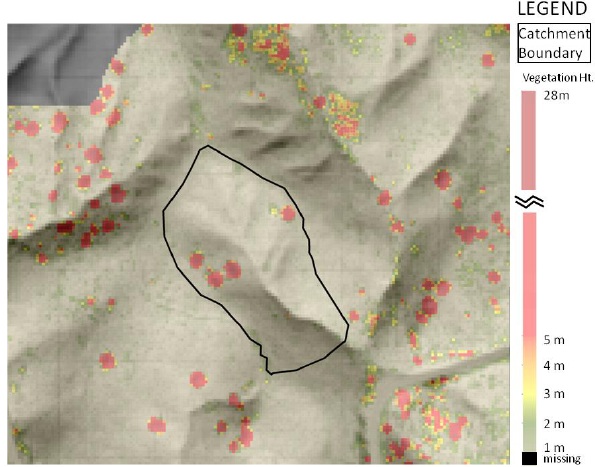
Figure 5. Aerial lidar-derived vegetation height over shaded topo- Figure 5. Aerial LiDAR-derived vegetation height over shaded topographic relief map. 2 graphic relief